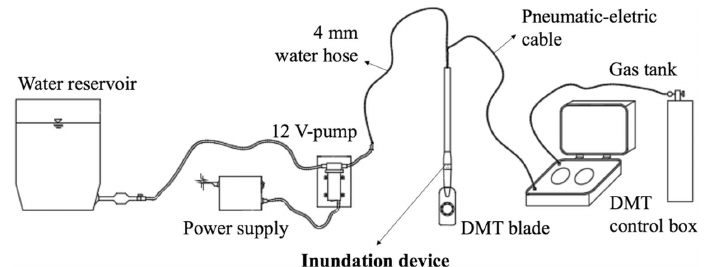
Figure 2. Schematic representation of the DMT test with the inundation device. Adapted from [32].